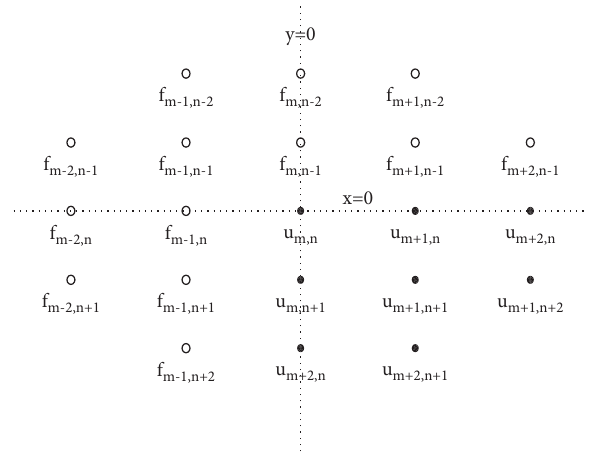
Figure 4: Illustration of the fictitious points for the new 21-point difference scheme along the horizontal, vertical, and diagonal directions,